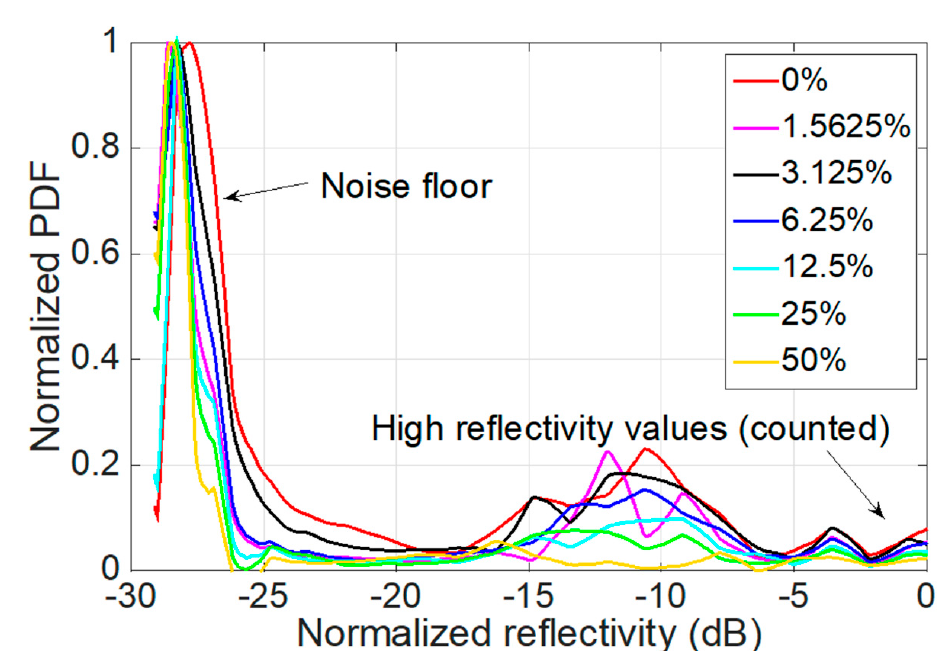
Figure 7. Normalized probability density function (PDF) estimated with sym6 one-dimensional wavelet estimator for each normalized MMEFBG spectral value (in dB).